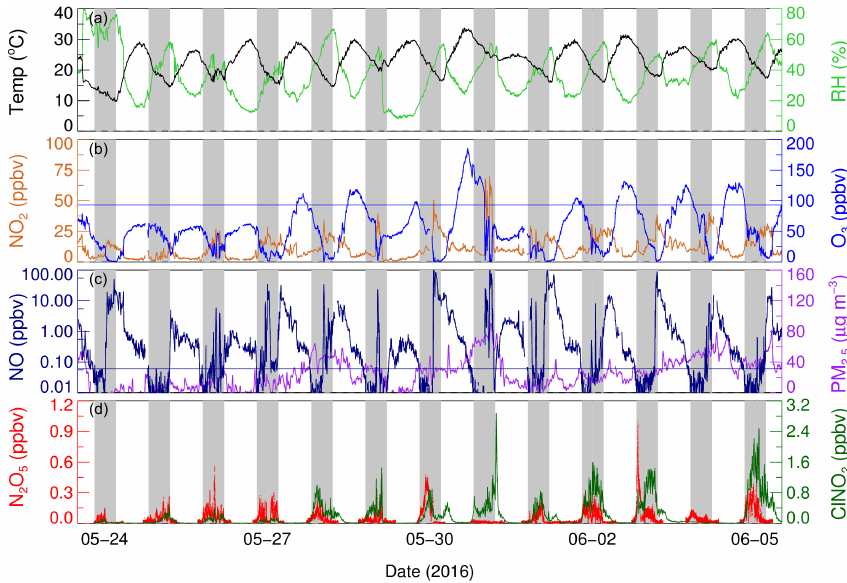
Figure 2. Time series of N 2 O 5 , ClNO 2 , and other relevant parameters. The blue line in the O 3 panel denotes the Chinese national air quality standard for O 3 (ca. 93ppbv for the surface conditions). The black line in the NO panel denotes 0.06ppbv.